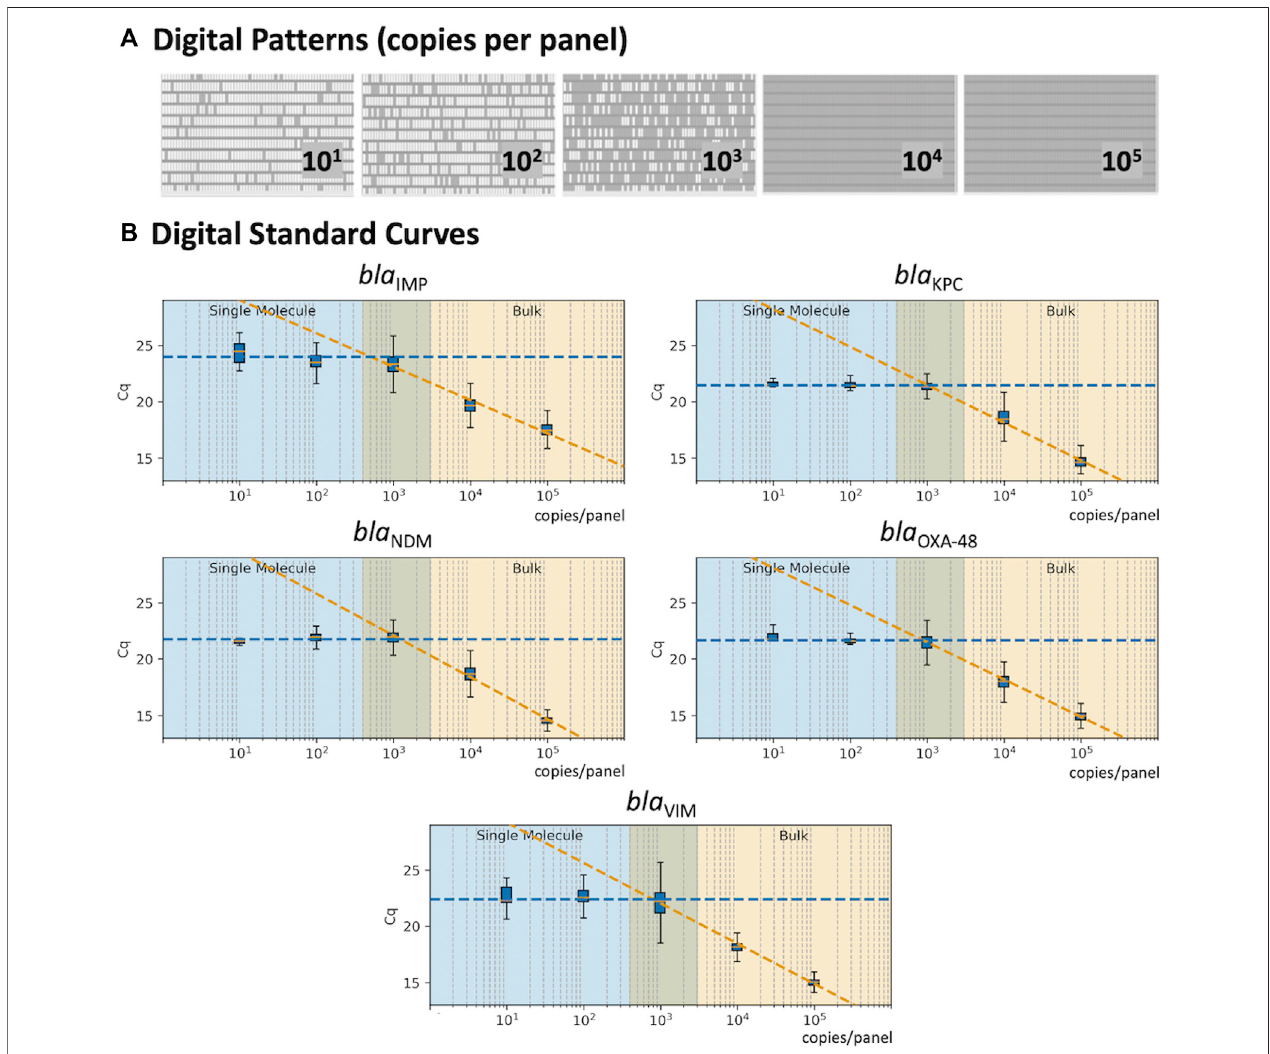
FIGURE2| Standard Curve in real-time digital PCR. (A) Digitalpatternsforeach micro fl uidic panelat increasingconcentrations(770 reaction chambersper panel; 0.85 nL volume per chamber). (B) Standard curves correlating the C q values with the concentration of each target; shaded blue area indicates the single-molecule region; shaded orange shows the bulk region; and the middle area displays the theoretical transition between the single-molecule and bulk.